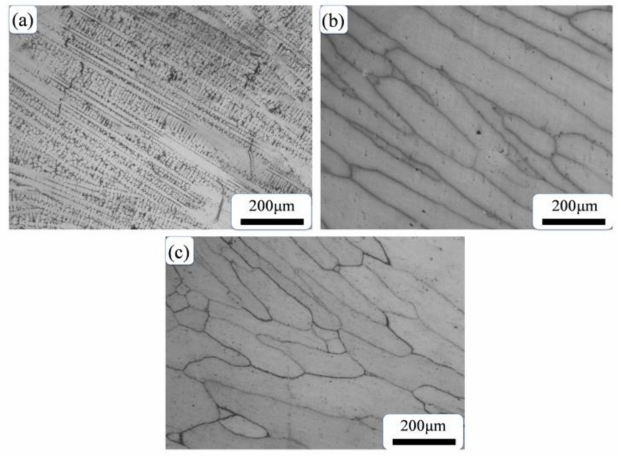
Figure 2. Optical micrographs of heat-treated nickel-based alloys: ( a ) Ni-Nb1; ( b ) Ni-Nb3; ( c ) Ni-Nb5.